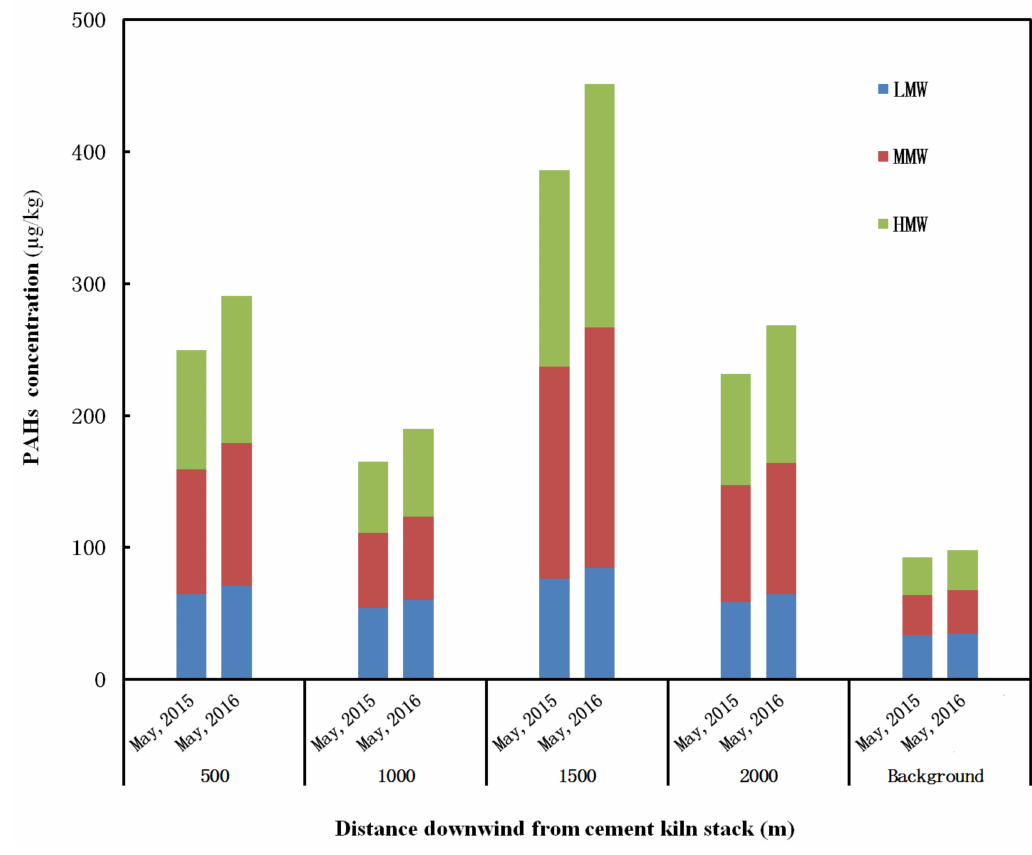
Figure 4. Polycyclic aromatic hydrocarbons concentration in soil in different sampling sites and